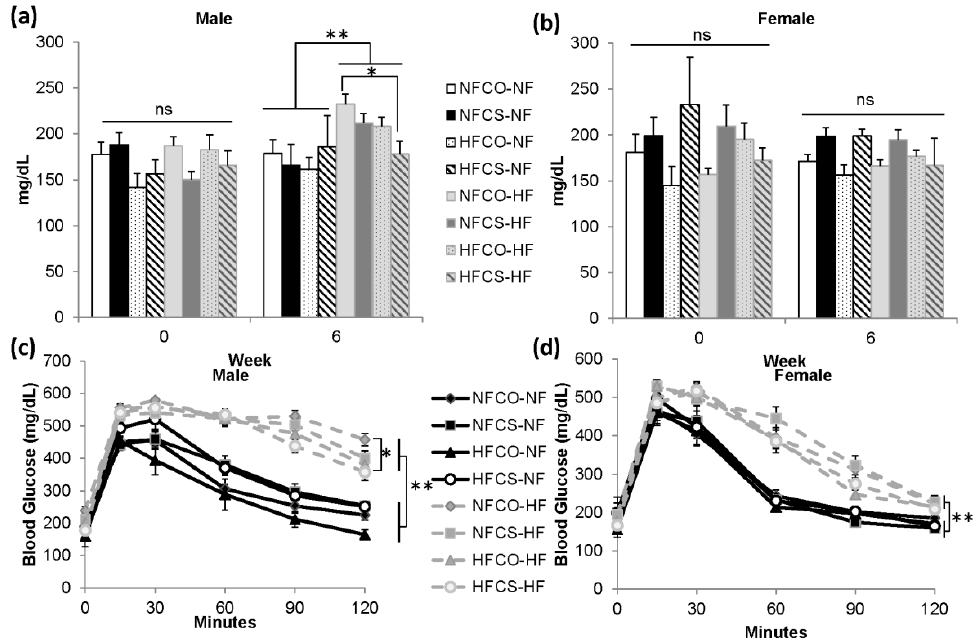
Figure 4. Blood glucose control of mouse offspring during the 6-week post-weaning feeding. ( a , b ) Fasting blood glucose at week 0 and week 6 of post-weaning feeding in male and female offspring. ( c , d ) intraperitoneal glucose tolerance at week 6 of post-weaning feeding in male and female offspring. n = 12 for the postnatal NF groups and n = 16–20 for the postnatal HF groups for each sex. Data were analyzed using the general linear model. Values represent means ± SEM. *, p < 0.05; **, p < 0.01; NF: normal fat; HF: high fat; CO: untreated control without choline; CS: choline supplemented.